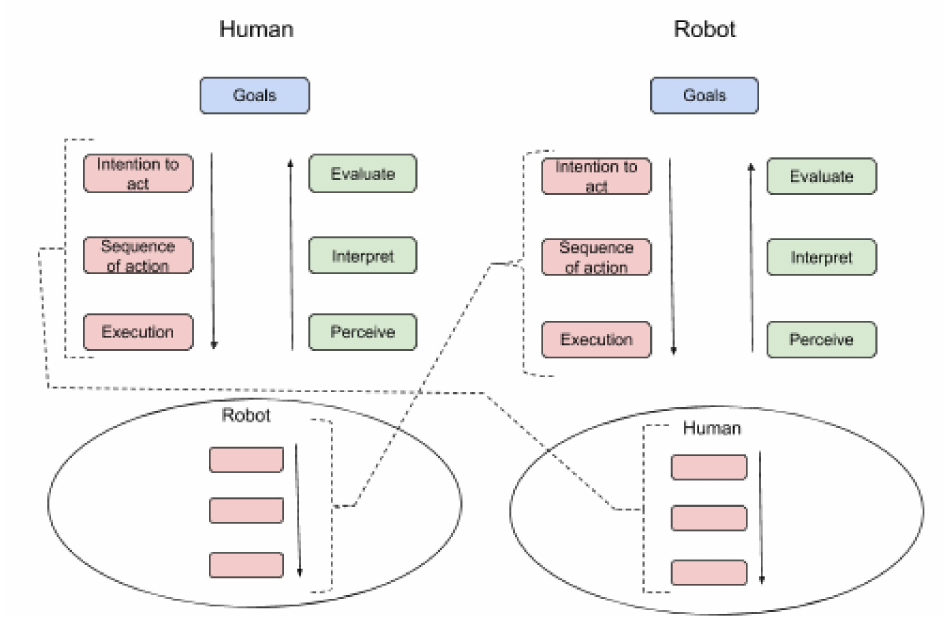
Figure 7. Expanding the seven stages of action model to mutual action and intention recognition between a human and a robot